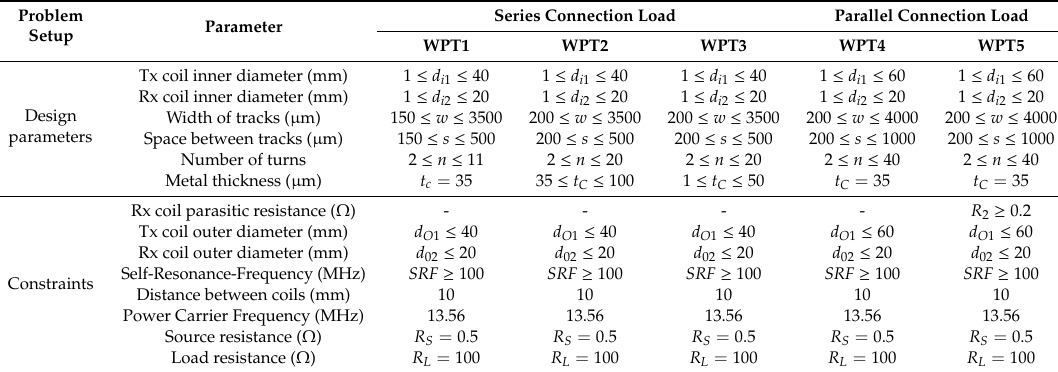
Table 1. Design parameters and defined